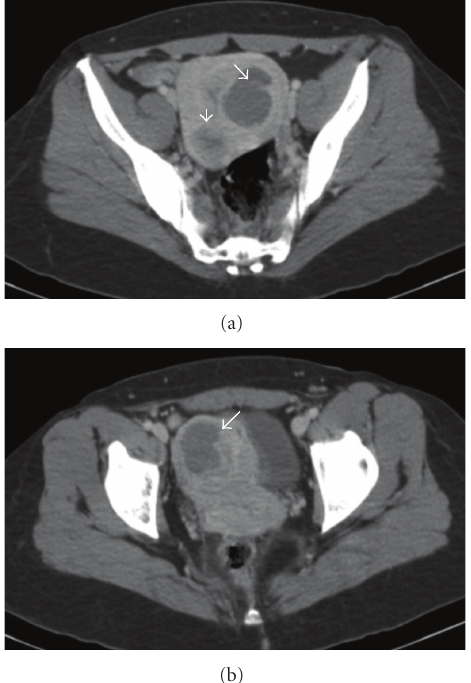
Figure 1: CT-scan of the abdomen, performed for GTN staging after two cycles of interval systemic methotrexate for hydatidiform mole. White arrows indicate the presence of three fibroids, resulting in important distortion of the uterine cavity. At this stage, no residual molar tissue was observed radiologically.